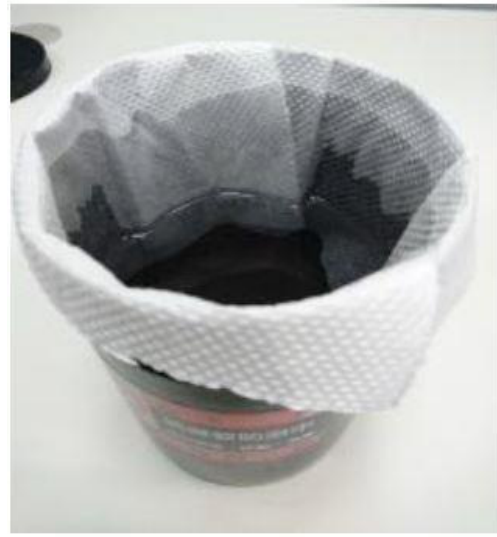
Figure A1. The snapshot of the ovitrap.